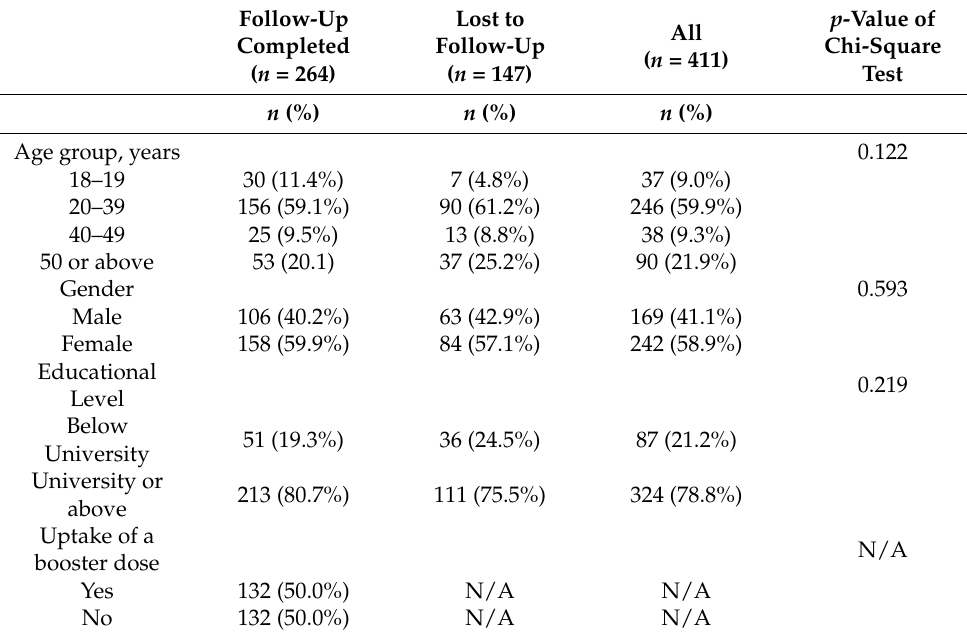
Table 1. Background characteristics of participants by follow-up status (among all participants who completed the baseline survey, n = 411) and prevalence of uptake of a booster dose ( n = 264).